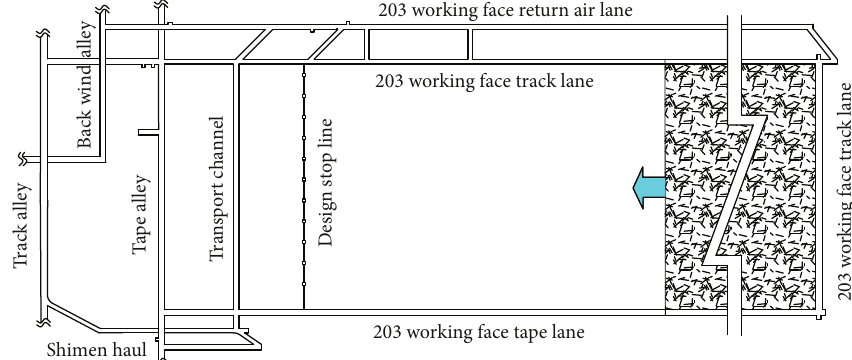
Figure 1: Roadway layout of the 203 working face.